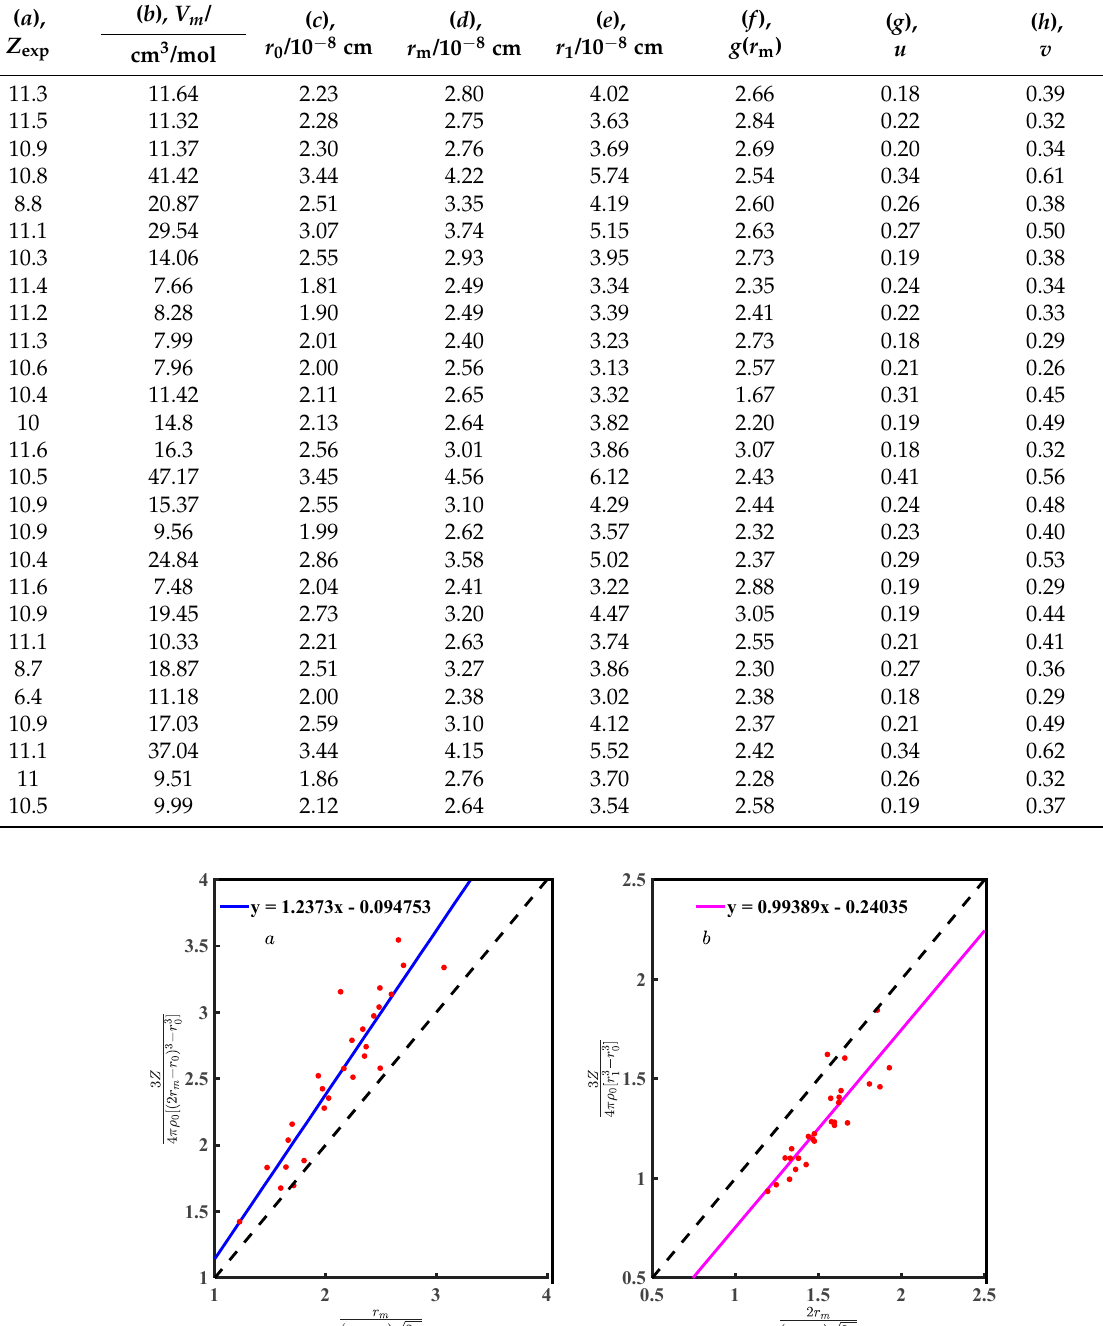
Figure 7. ( a ) Relationship between Equations (7) and (10); and ( b ) relationship between Equations (19) and (22).